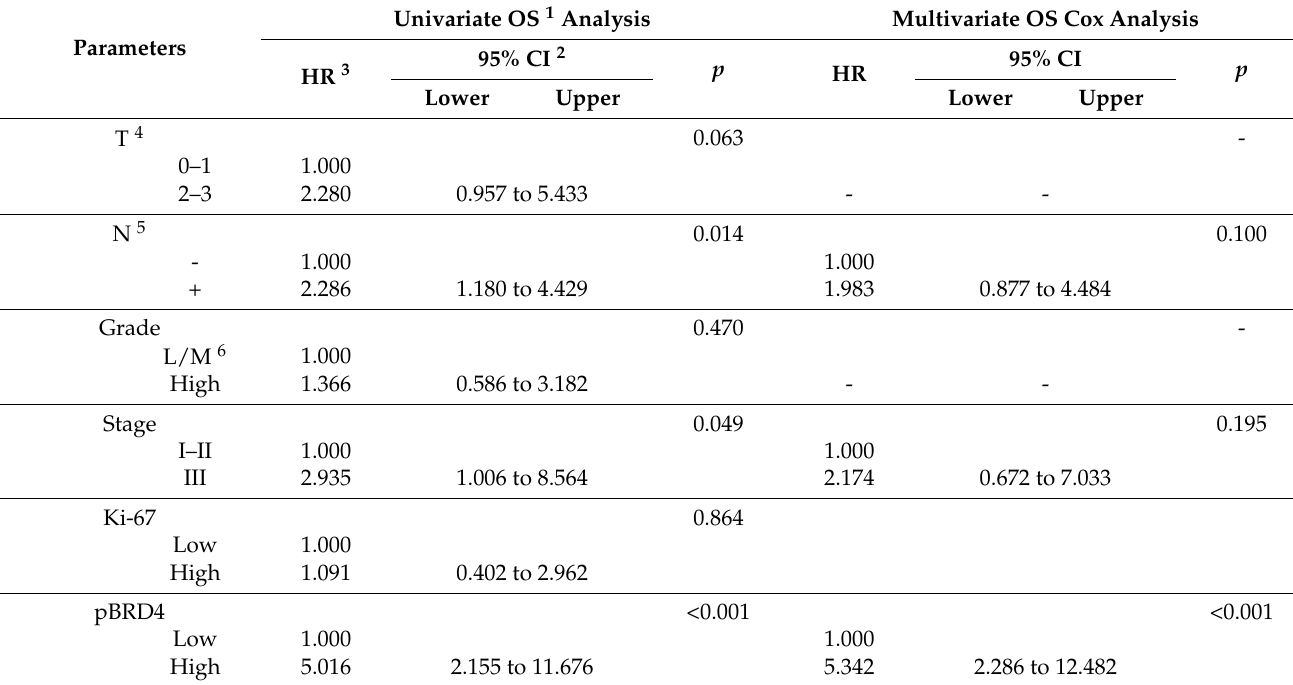
Table 2. Univariate and multivariate Cox analyses in the cohort of 132 TNBC